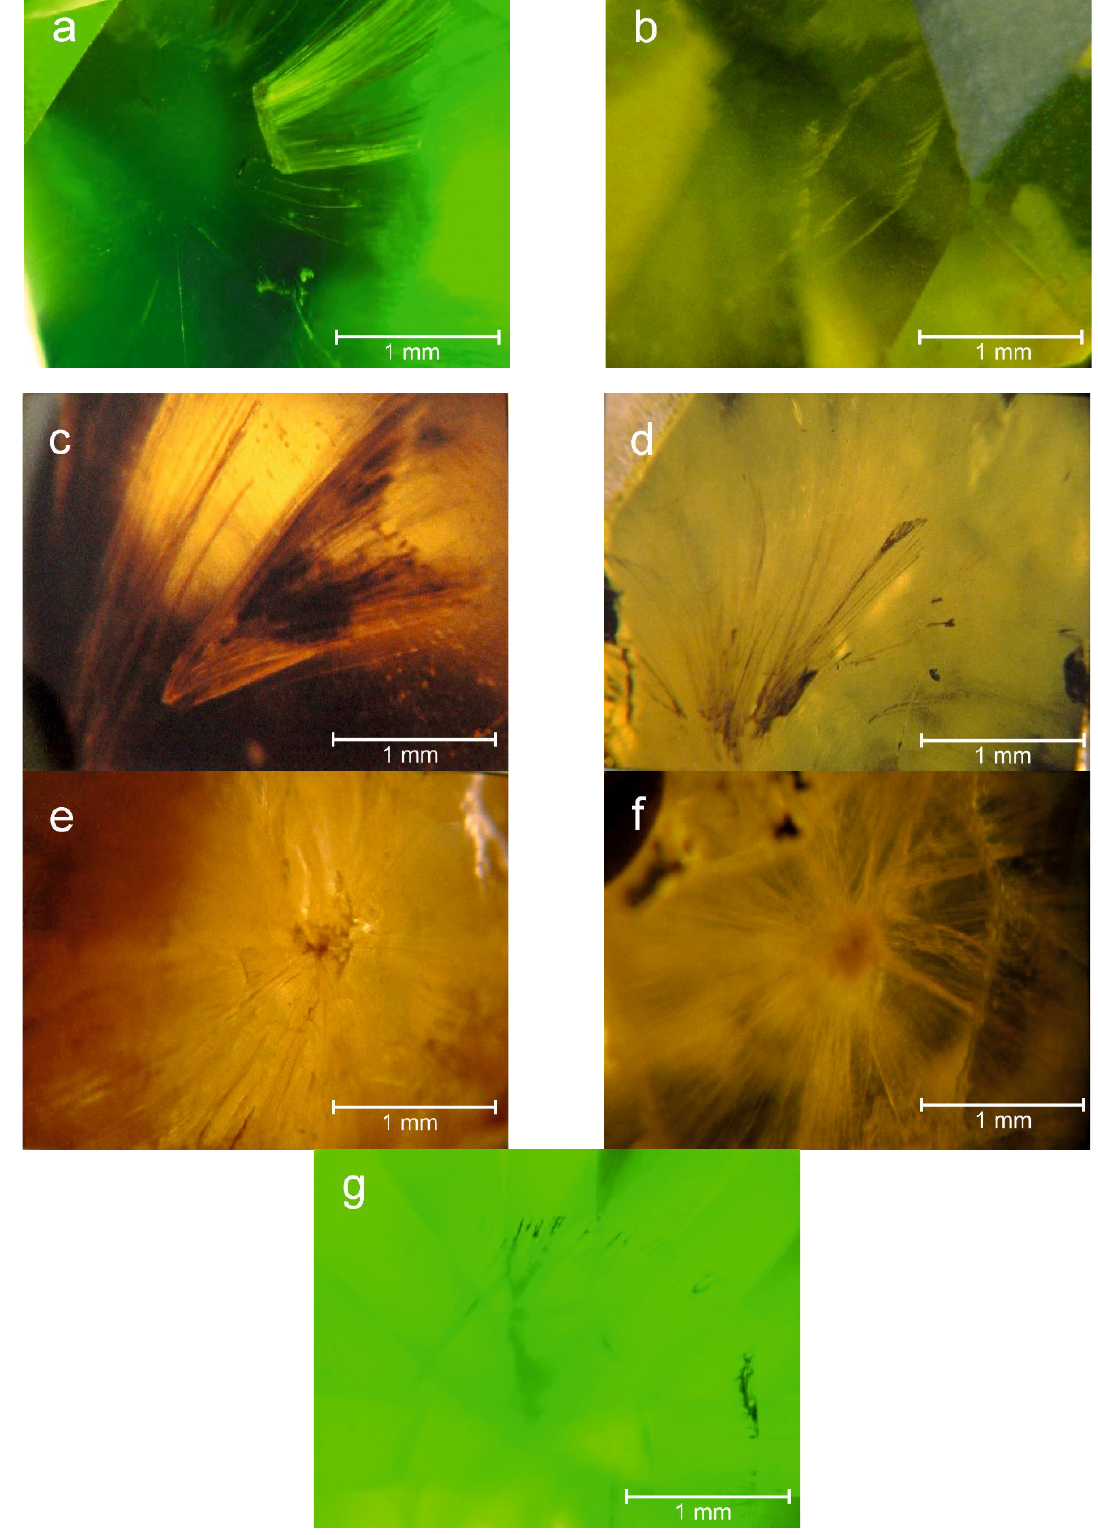
Figure 7. Features of “horsetail” inclusions revealed by optical methods: ( a ) “horsetail” inclusions start from the reflecting surface of the crystal phantom (stone 2 in Figure 4a); ( b ) curtains of threadlike inclusions; ( c ) v-shaped dark-brown inclusion in annealed stone; ( d ) inclusion in annealed stone; ( e , f ) colored inclusions in the demantoids from alluvial placers; and ( g ) dark, opaque ends of “horsetail” inclusions, exiting to the polished surface (stone 1 in Figure 4a).